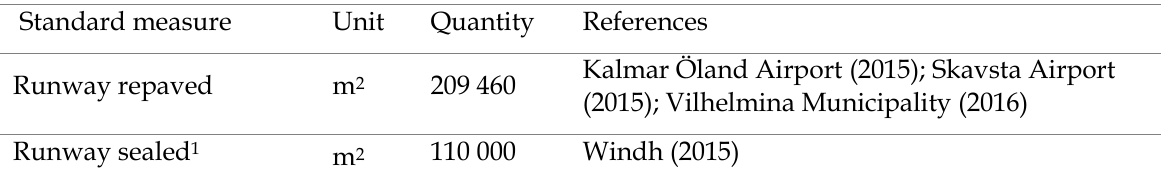
Table A9. Reinvestment of air transport infrastructure in 2015: resulting inventory of standard